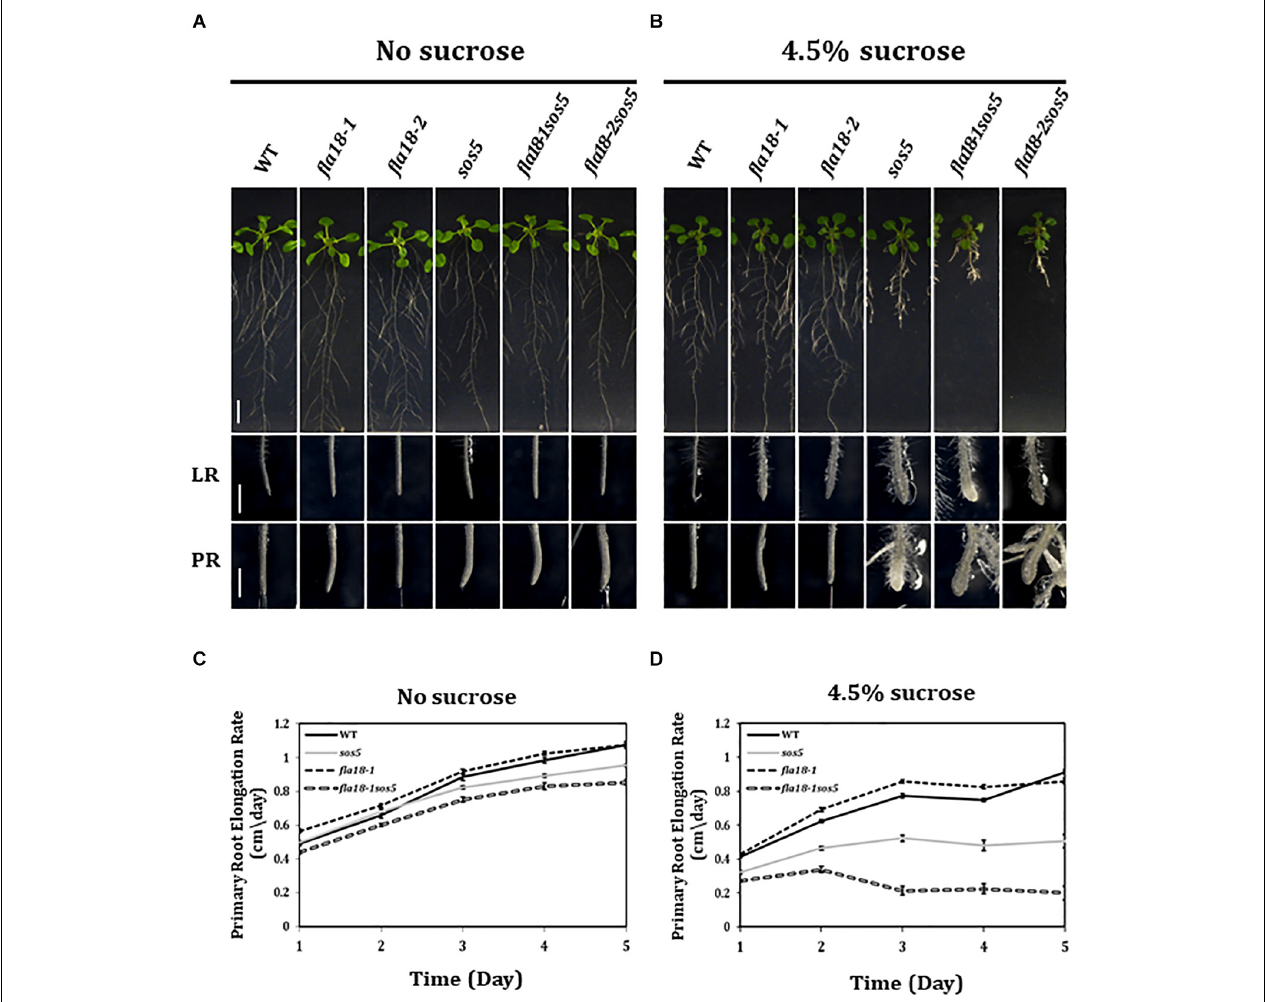
FIGURE 2 | fla18sos5 double mutants impart a synergistic effect on root elongation. (A,B) Seedlings of the indicated genotypes were grown on sucrose-free MS medium for 4 days and then transferred to either fresh sucrose-free medium ( A ; permissive conditions) or medium containing 4.5% sucrose ( B ; restrictive conditions), for an additional 7 days. Whole seedlings (upper panel), lateral root tips (LR, middle panel) and primary root tips (PR, lower panel) were documented. Note, the synergistic effect of the double mutant on both PR and LR elongation and swelling. (C,D) Seedlings of the indicated genotypes were grown on MS medium for 4 days and then transferred to sucrose-free MS medium (C) or MS medium plus 4.5% sucrose (D) . Root length was measured daily and elongation rate was calculated; n = 10 ( fla18-1 ; n = 5). Error bars represent SE. Scale bars = 1 cm ( A,B ; upper panel) and 1 mm ( A,B ; middle and lower